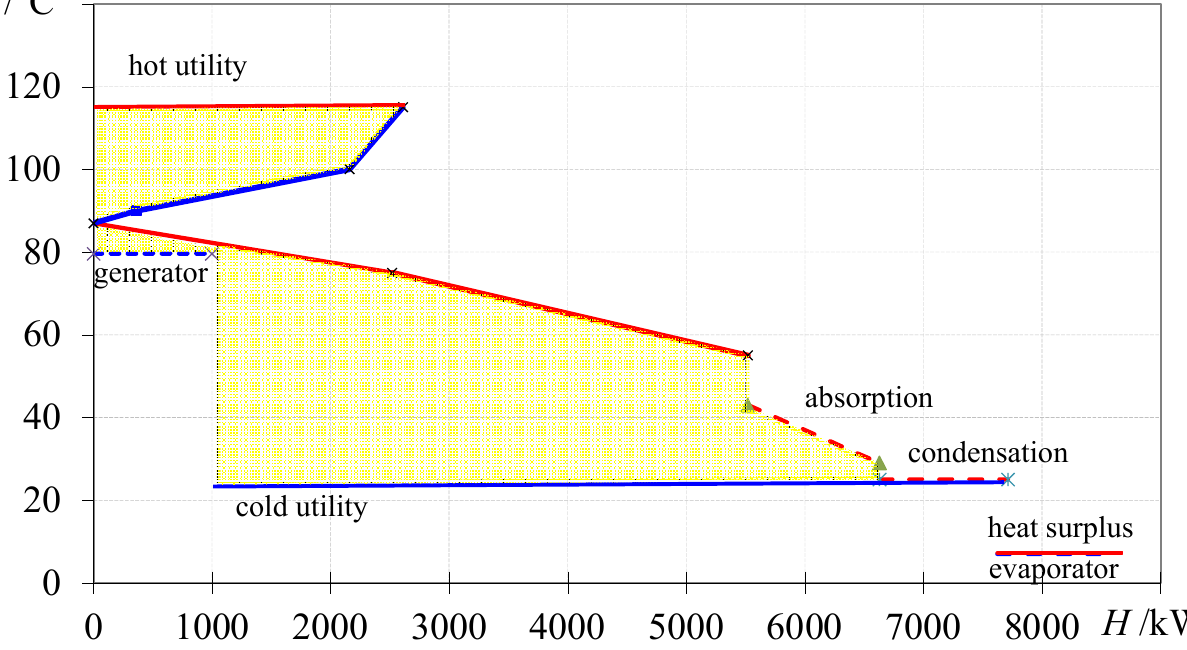
Table 5. Input data for the process streams for case study 2. Stream